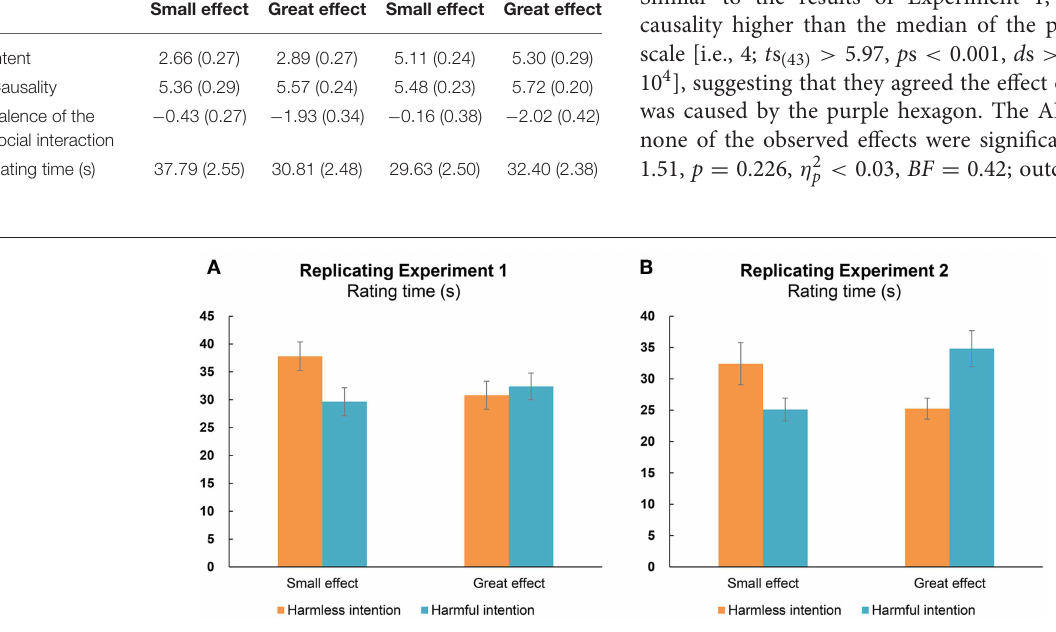
FIGURE 4 | Rating times about completing the questions regarding intent, causality, and valence of social interactions under different acting conditions, in replicating Experiment 1 (A) and Experiment 2 (B) . Error bars indicate the standard errors ( ± SE).